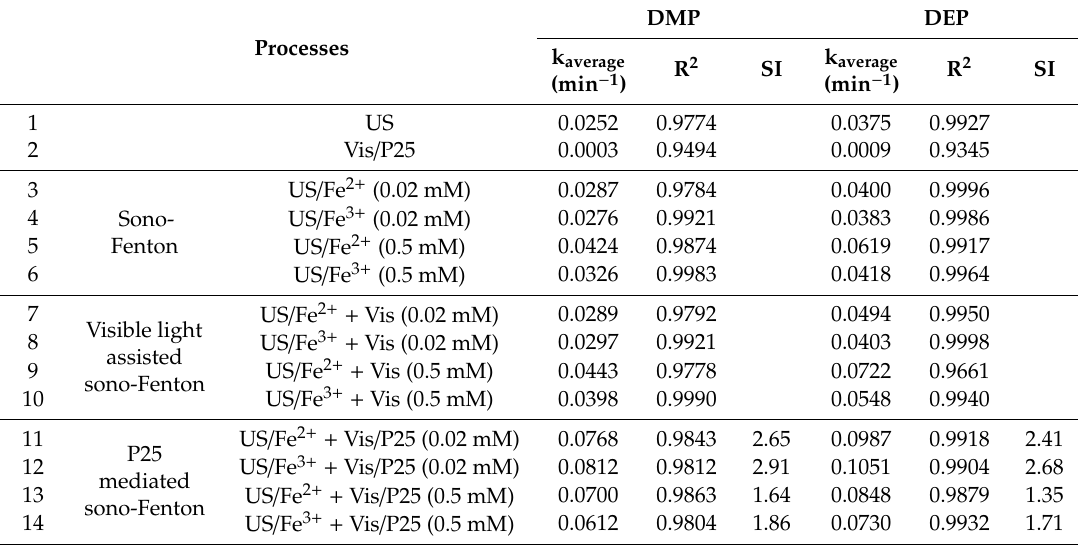
Table 1. The pseudo first-order degradation rate constants of both DMP and DEP in US and sono-Fenton processes with two di ff erent iron levels (0.02 mM and 0.5